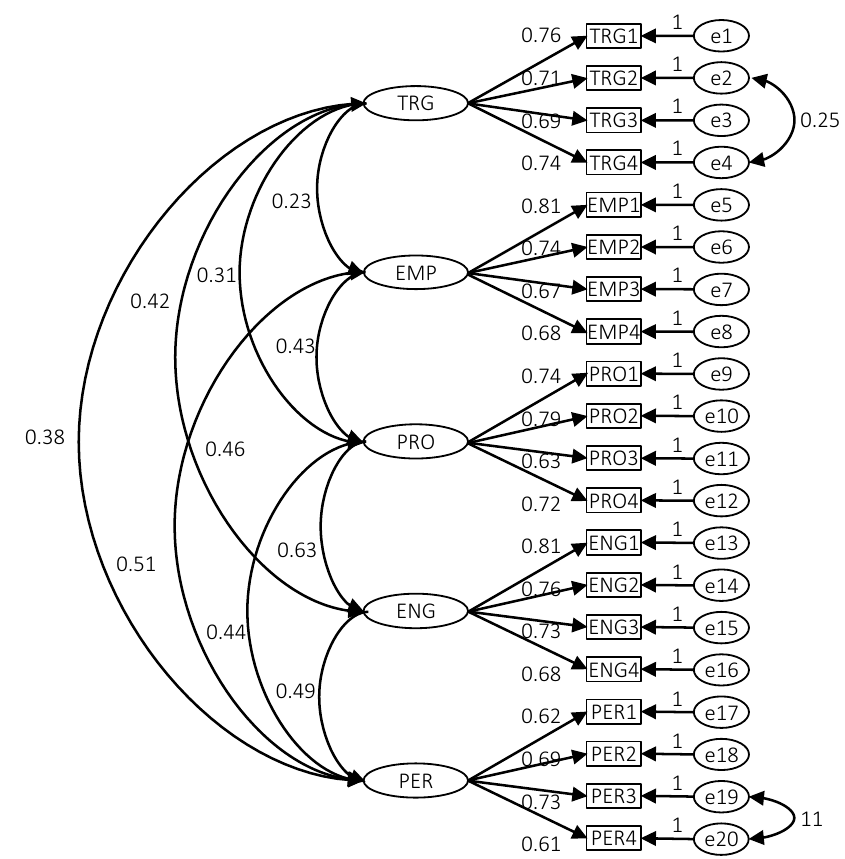
Figure 2. Research measurement